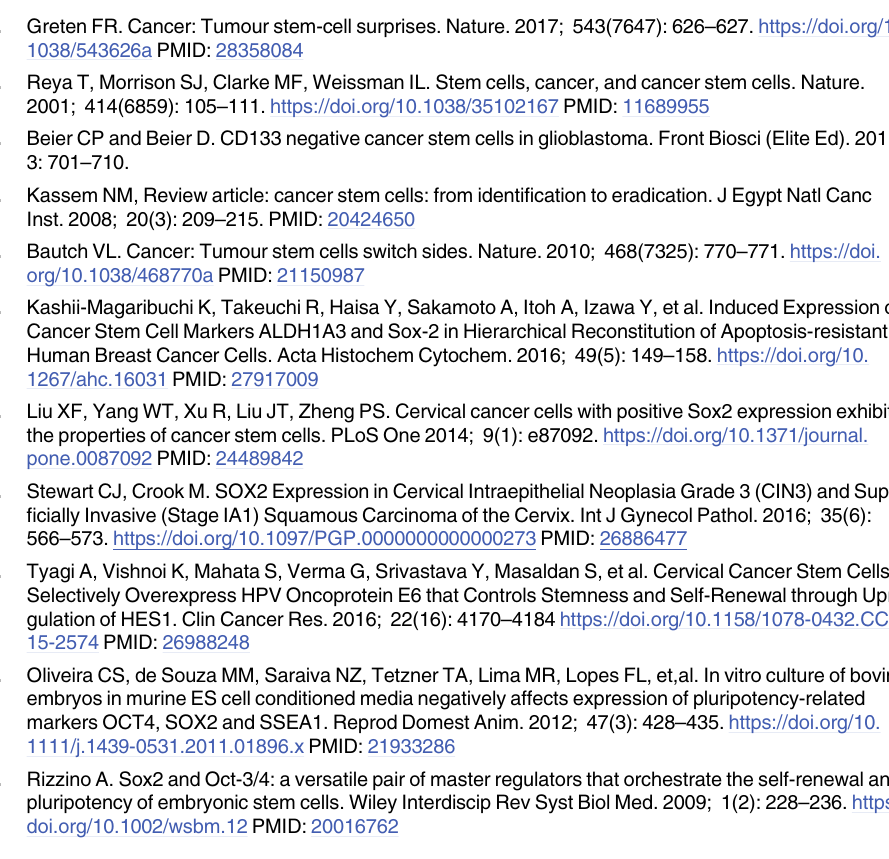
S1 Table. The primer sequences used in the SOX2 promoter deleted and mutated plas-